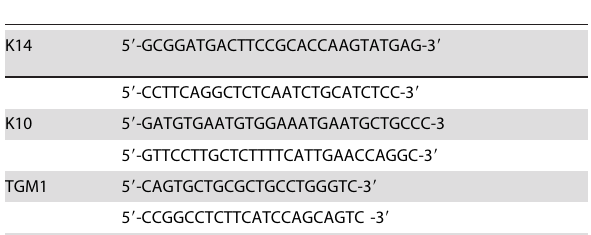
Table 1. Sequences of primers used for qPCR